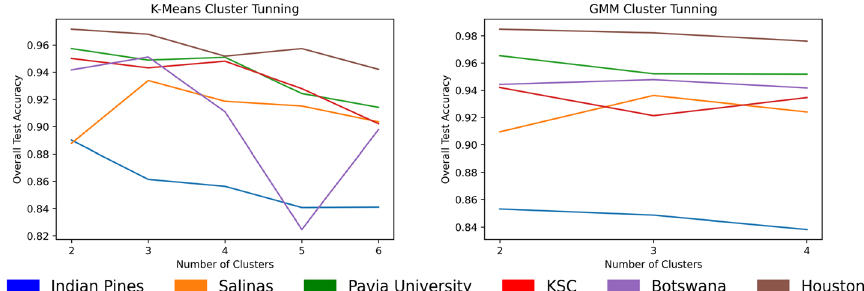
Fig. 3 Results of our cluster tuning. We explored both K-Means and Gaussian Mixture Models (GMM) for our clustering methods along with a wide spread of cluster numbers. Any cluster larger than 4 for GMM or 6 for K-Means resulted in clusters with too little data for semantic segmentation in specific sub-U-Nets. The number of clusters cannot equal 1, as this would result in the entire dataset being the only cluster and therefore an ensemble CEU-Net approach would not be possible. The relatively small number of clusters in each dataset shows how easily segmentable these datasets